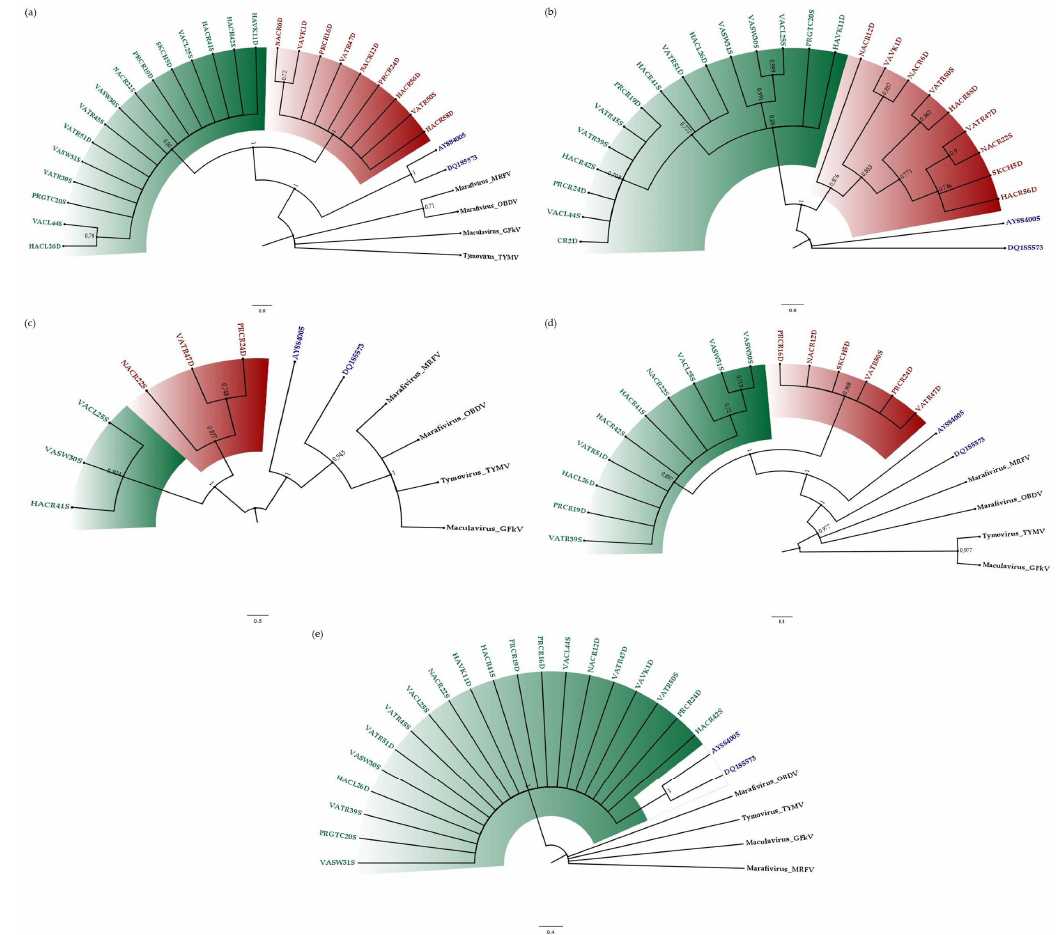
Figure 2. Bootstrap majority rule (70%) consensus trees reconstructed by the neighbor joining method for five genomic regions of CSDaV isolates including field collected and reference sequences. Bootstrap support values (1000 iterations) of main branches are indicated. ( a ) MT segment; ( b ) MDR segment; ( c ) He segment; ( d ) RdRP segment; ( e ) CP segment. CSDaV groups are highlighted by different colors: Group I = green; Group II = red. The CSDaV reference isolates are represented in blue. The outgroups are represented in black. Isolates from asymptomatic plants are identified by letter S at the end of their identification names. Isolates from symptomatic plants are identified by letter D at the end of their identification names.